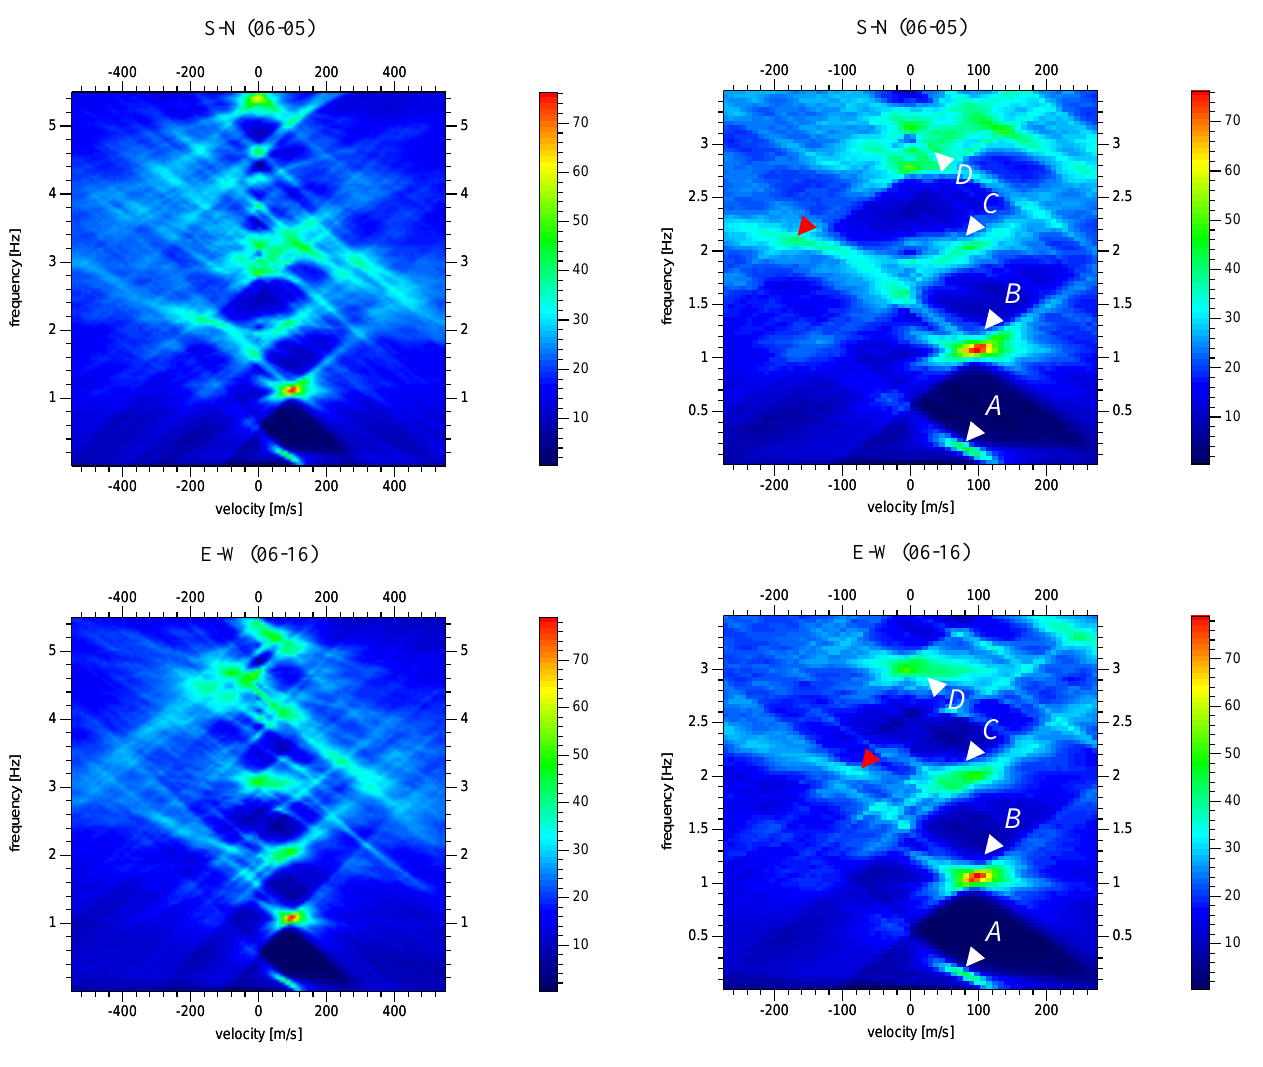
Fig. 10. Magnified part of Radon transform from Fig. 9 with marked maxima.